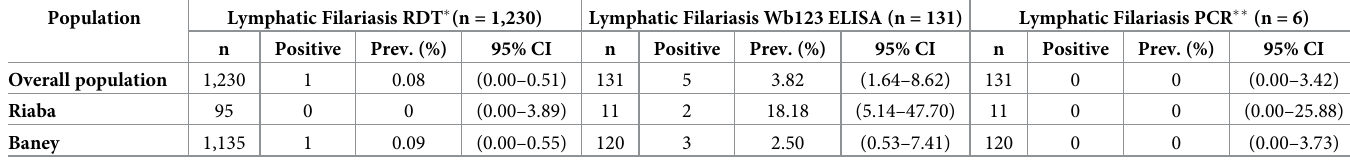
Table 3. Prevalence of lymphatic filariasis in children younger than 10 years old tested by LF IgG4/biplex RDT, ELISA and PCR, Bioko Island, September 2016 to January 2017.